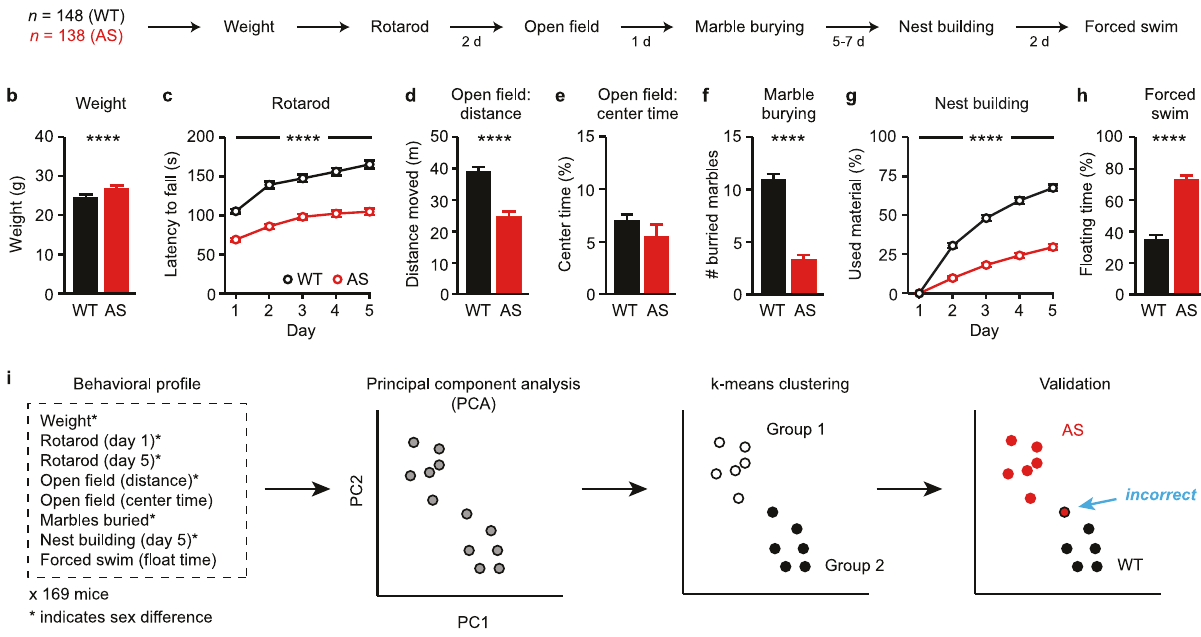
Fig. 1 Ube3a m-/p + mice have robust behavioral impairments across multiple domains. a Experimental timeline, as described and performed by Sonzogni et al. (eight cohorts), plus two additional unpublished cohorts. b Weight (WT: n = 118, AS: n = 110). c Rotarod performance